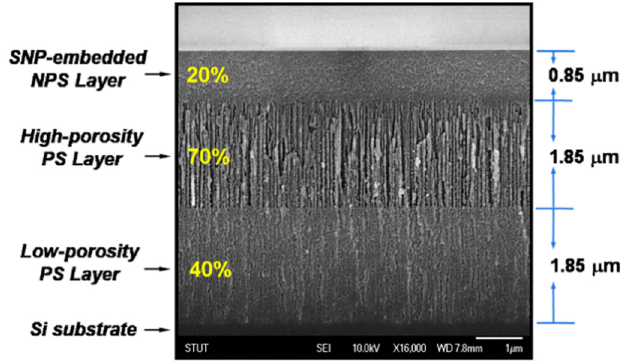
Figure 1. The SEM photo-image of the cross-sectional view of the formed triple-layered (NPS), a high-porosity PS and a low-porosity PS layer from top to bottom.